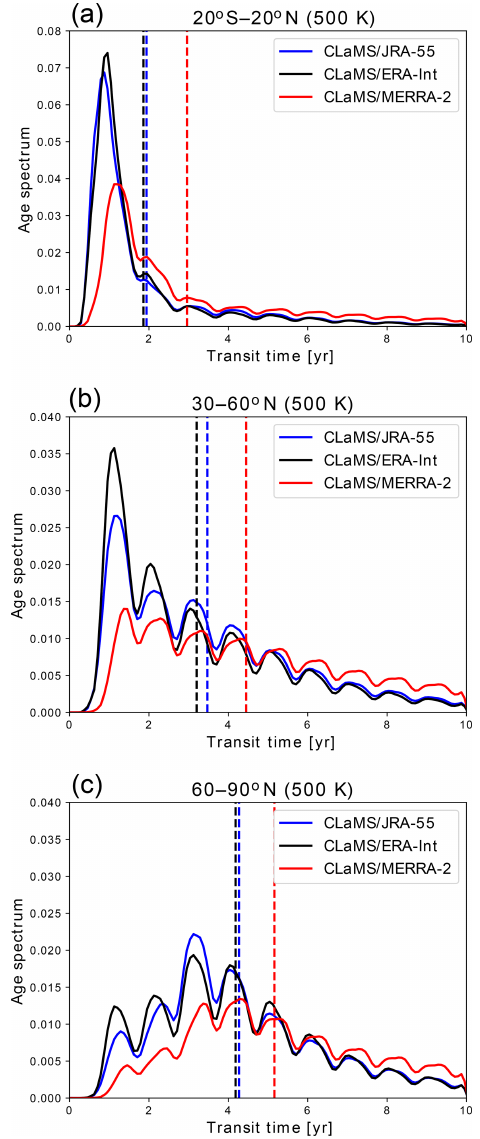
Figure 2. Age spectrum on the 500K potential temperature surface for December–February in (a) the tropics between 20 ◦ S and 20 ◦ N, (b) middle latitudes between 30 and 60 ◦ N and (c) polar regions between 60 and 90 ◦ N. Different colours represent different reanal- yses (ERA-Interim is shown using black, JRA-55 is shown using blue and MERRA-2 is shown using red). Vertical dashed lines in- dicate the respective mean age. (Note the different y axis range for tropical and extratropical